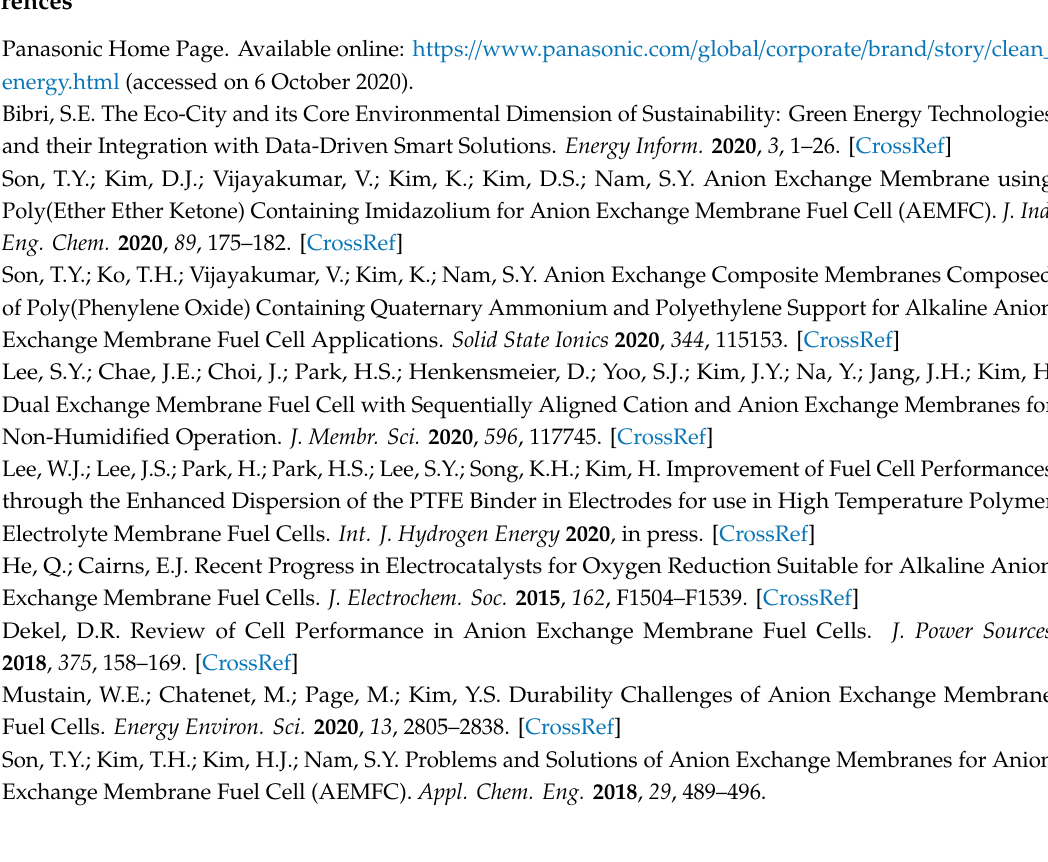
Figure S1: FE-SEM and EDS images of crosslinked pore-filled membrane